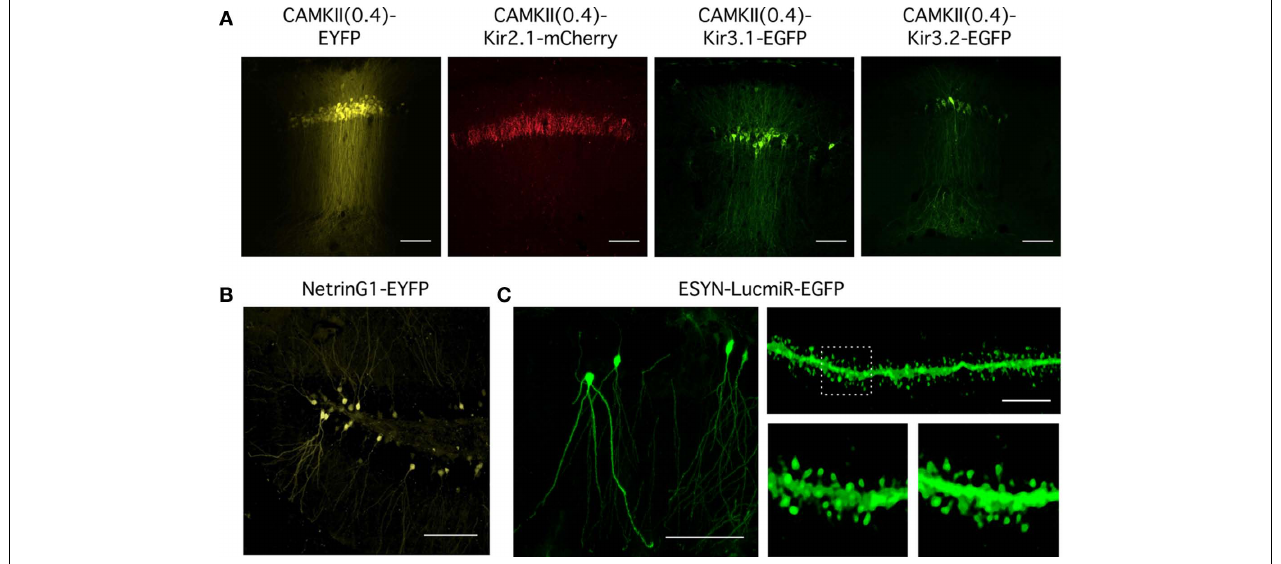
driven by the ESYN promoter. Reporter protein expression is bright enough to enable imaging of dendritic spines (upper and lower right panels). Higher magnification spine images (lower right panel) correspond to different depths from a Z-stack of the region indicated by the white box (upper right panel). Scale bars = 100 μ m for all images except the spine image, where the scale bar = 5 μ